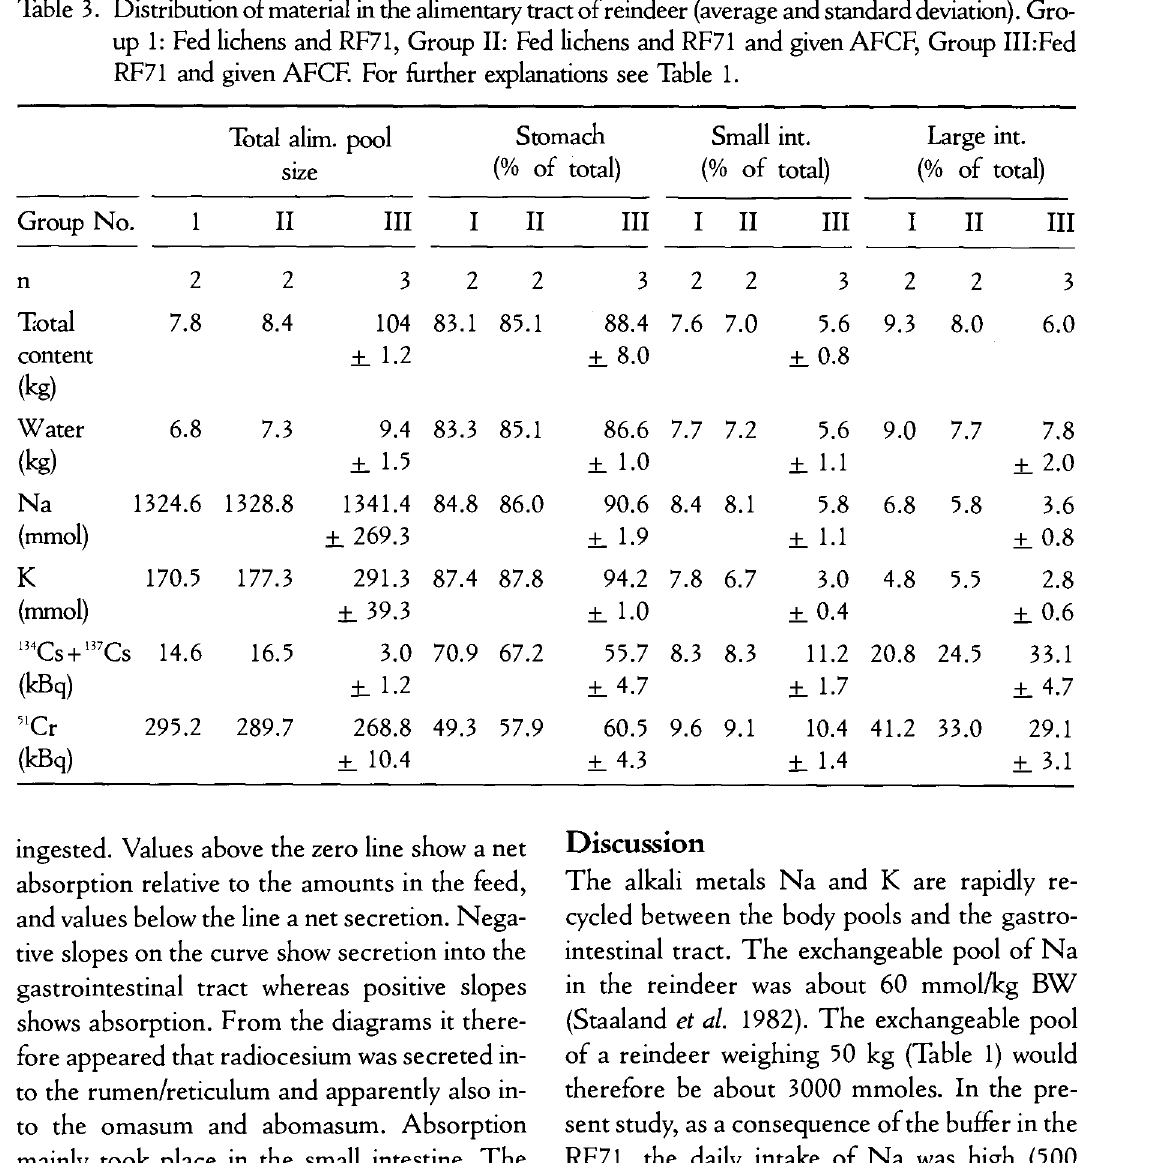
Table 3. Distribution of material in the alimentary tract of reindeer (average and standard deviation). Gro up 1: Fed lichens and RF71, Group II: Fed lichens and RF71 and given AFCF, Group III:Fed RF71 and given AFCF. For further explanations see Table 1. Total alim. pool Stomach Small int. Large